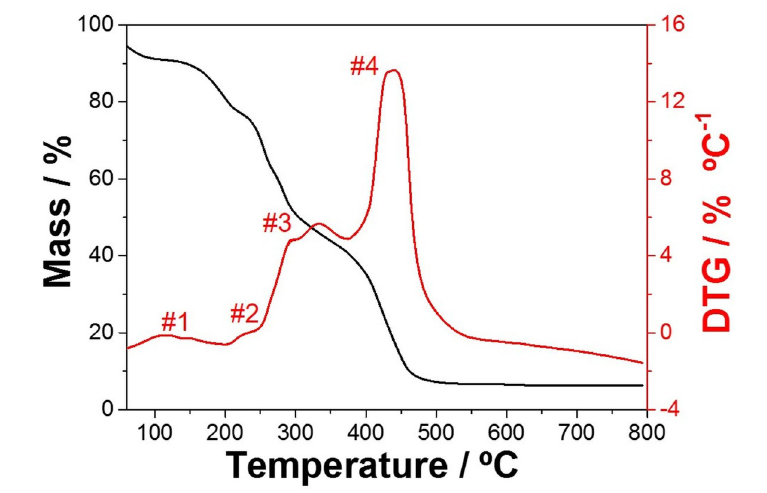
Figure 1. Thermogravimetric profile of the evaluated PVA:OAN fibers. Once the PVA degradation behavior against heat treatment was verified, the mor- phology of the Nb 2 O 5 fibers was analyzed. Thus, fibers were submitted in an annealing treatment from 400 ◦ C to 900 ◦ C for 2 h, with a fixed heating rate of 10 ◦ C min − 1 . The SEM images results (Figure 2) show the fiber format leakage and the consequent formation of the particles with the calcination temperature increasing. The predominance of fiber morphology is observed at temperatures from 400 ◦ C to 700 ◦ C, and agglomerates at higher temperatures. Additionally, the fiber average diameters obtained from 400 ◦ C to 700 ◦ C was 170, 140, 150, and 120 nm, respectively. However, when the temperature was raised to 800 ◦ C, the formation of a more significant number of shapeless particles with an average diameter of 135 nm was verified. Furthermore, the fiber loss format was observed after 900 ◦ C, which led to the particulate material formation.